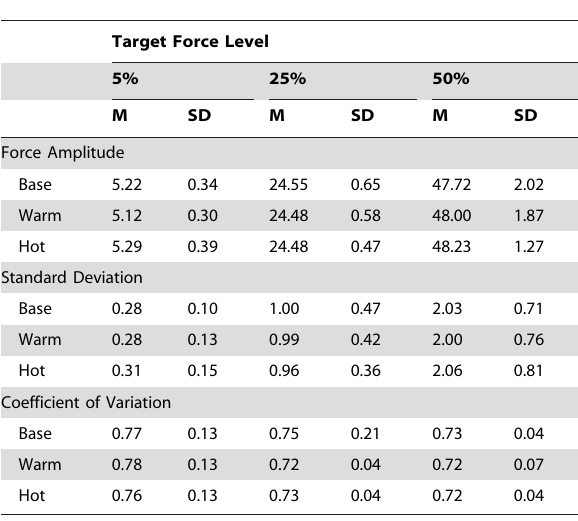
Table 3. Mean force amplitude, standard deviation, and coefficient of variation of force production at each temperature and each target force